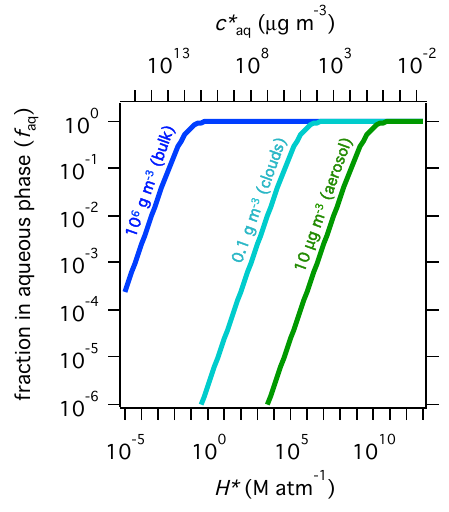
Figure 1. The fraction of a compound that will partition to the aqueous phase ( f aq ) as a function of its Henry’s law con- stant, H ∗ (or alternatively its saturation vapor concentration, c ∗ aq ) , and the liquid water content (LWC). Compounds with 0.1Matm − 1 < H ∗ <10 9 Matm − 1 will be primarily in the aqueous phase at bulk LWC (blue line), but primarily in the gas phase at aqueous aerosol LWC (green line). Cloud water (teal line) repre- sents the intermediate case, with more partitioning into the aqueous phase than for aqueous particles, but still with far less than for a bulk aqueous